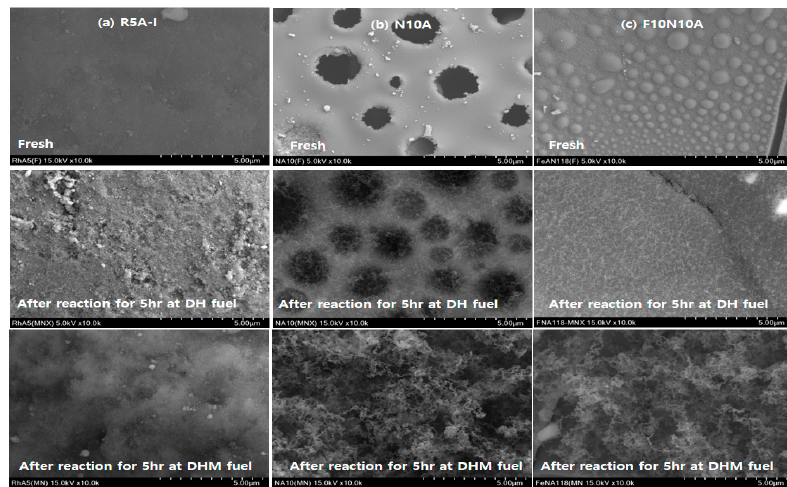
Figure 3. Scanning electron micrographs of ( a ) R5A-I, ( b ) N10A, and ( c ) F10N10A.